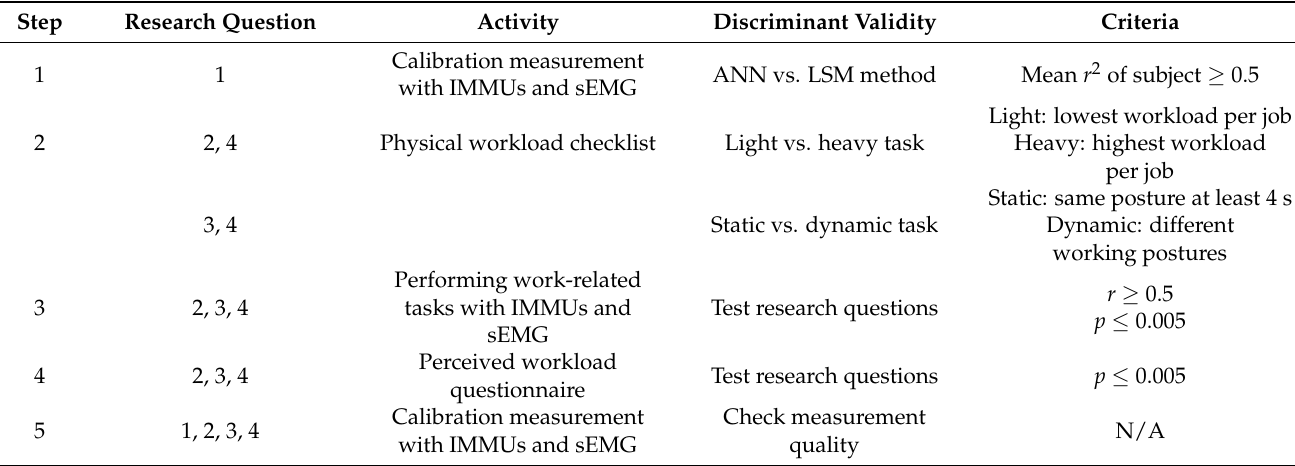
Table 1. Framework study design. A framework to describe per research question the activities in terms of inertial magnetic measurement units (IMMUs) and surface electromyography sensors (sEMG)), discriminant validity and related criteria with artificial neural network (ANN) and linked segment model